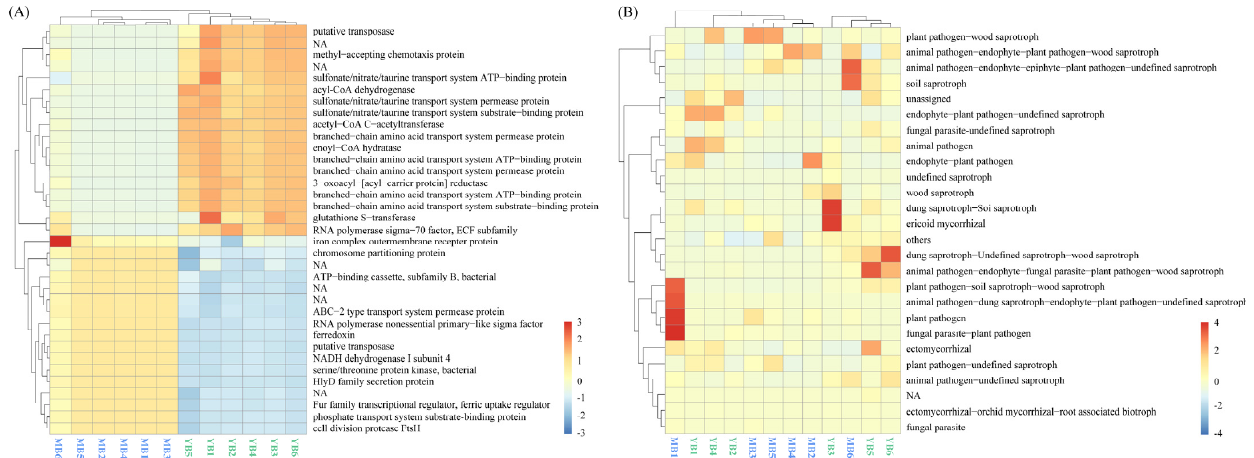
Figure 7. Heat map of clustering of differential metabolites of endophytic bacterial ( A ) and fungal ( B ) communities in young and mature branches of Nitraria tangutorum . ( B ) communities in young and mature branches of Nitraria tangutorum